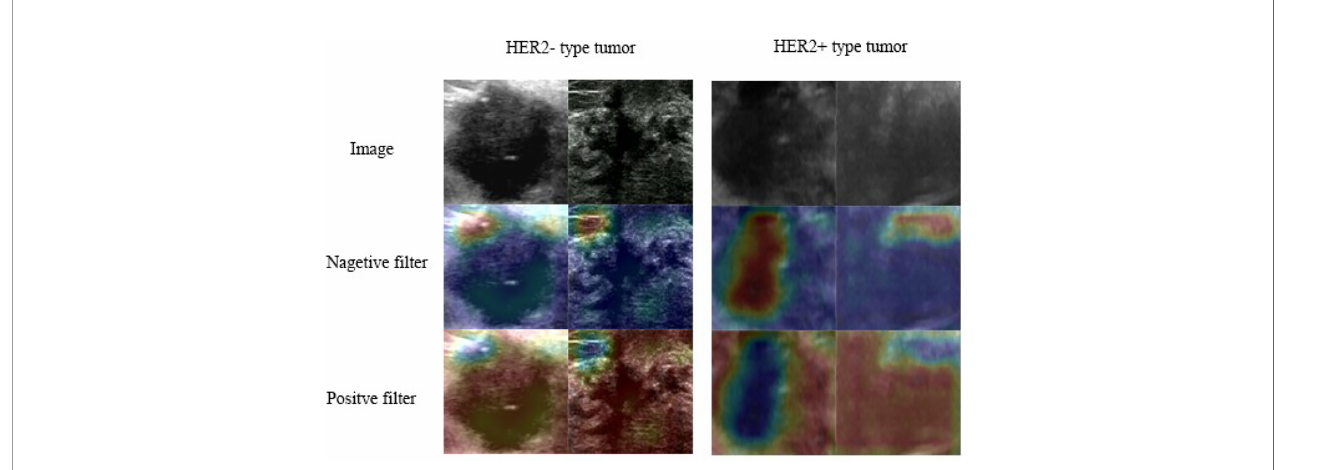
FIGURE 2 | Class activation heat map: the attention map of the trained model for predicting HER2